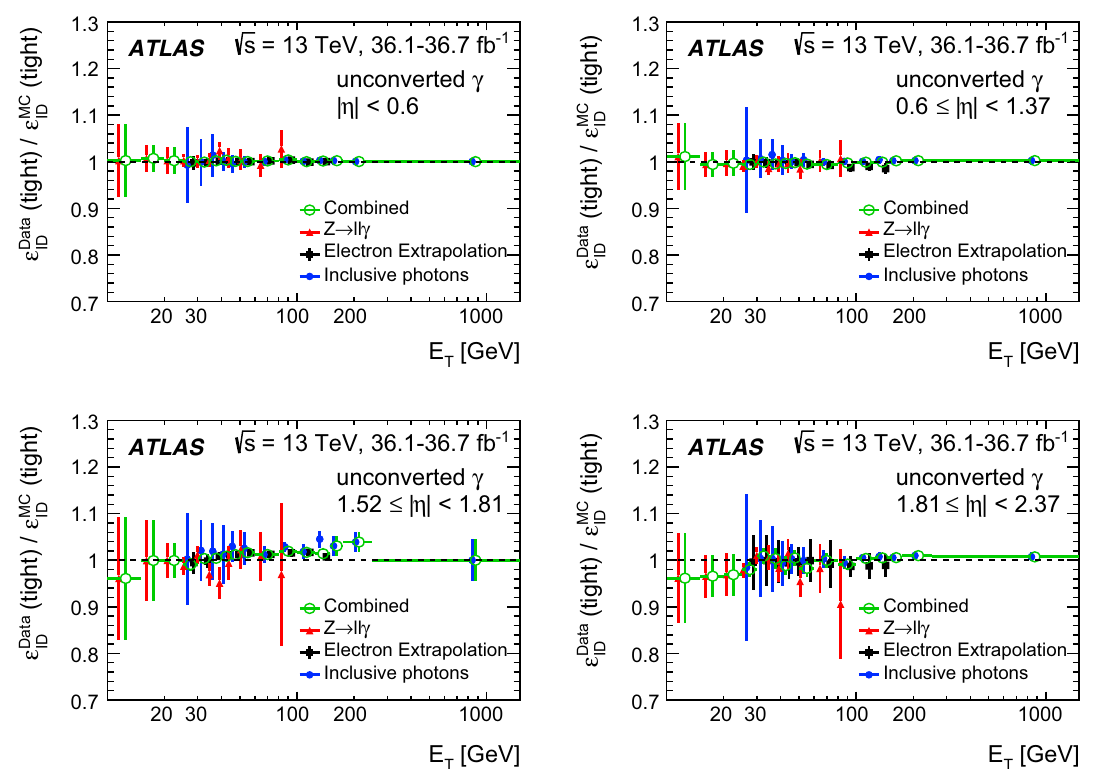
Fig. 13 Efficiency scale factors (SF) for each method and their combination for unconverted photons. The last bin extends to 1.5 TeV